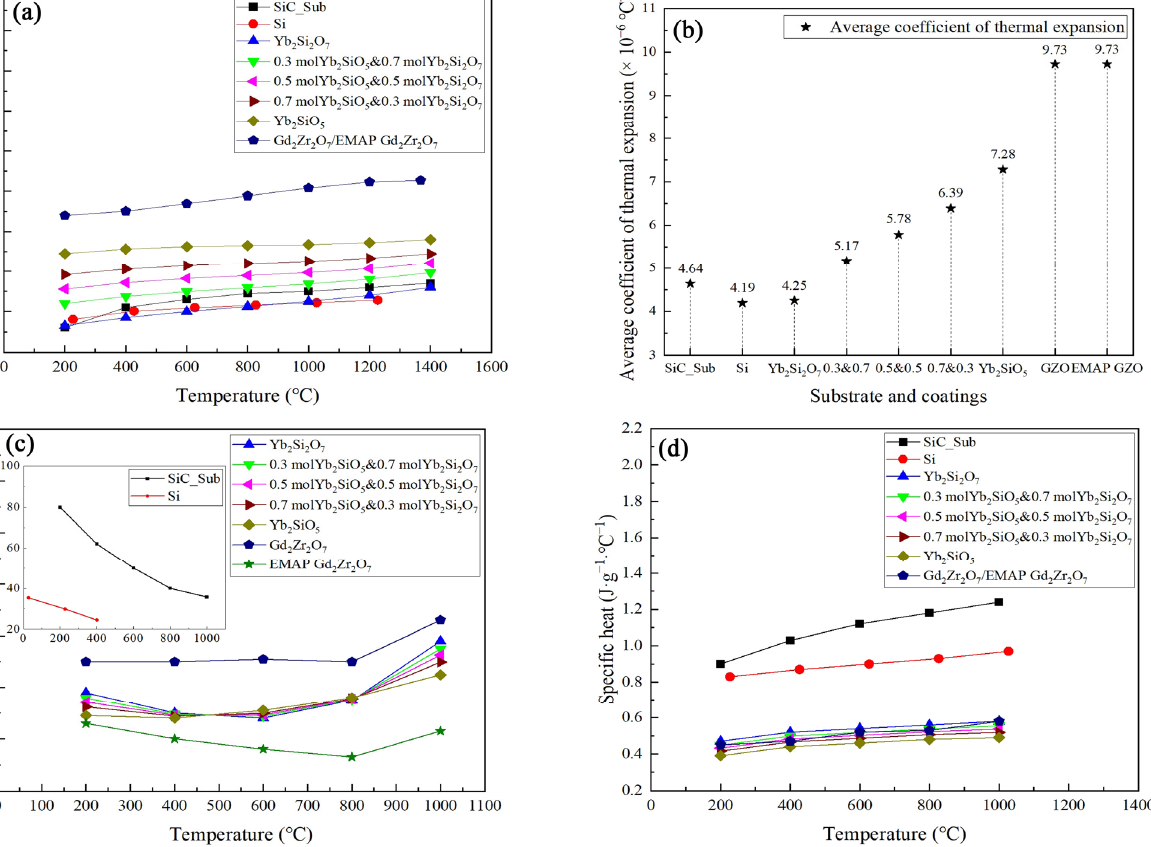
Figure 5. Distributions of thermally related parameters of materials: ( a ) CTE; ( b ) average CTE (200– 1400 °C); ( c ) thermal conductivity; ( d ) specific